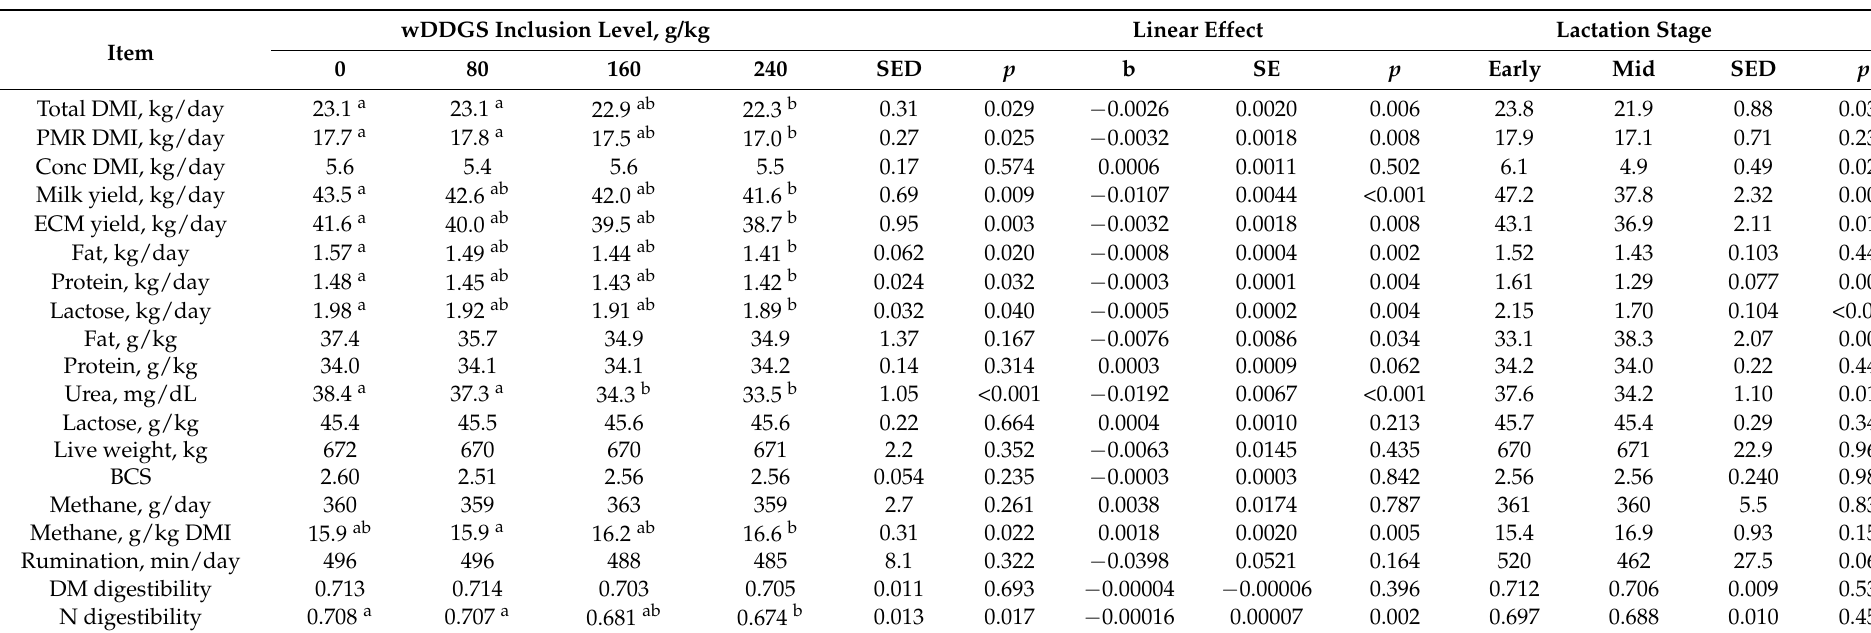
Table 3. (Experiment 1) Mean feed intake and performance of cows in early or mid-lactation when fed on diets containing 0 to 240 g wDDGS DM/kg diet